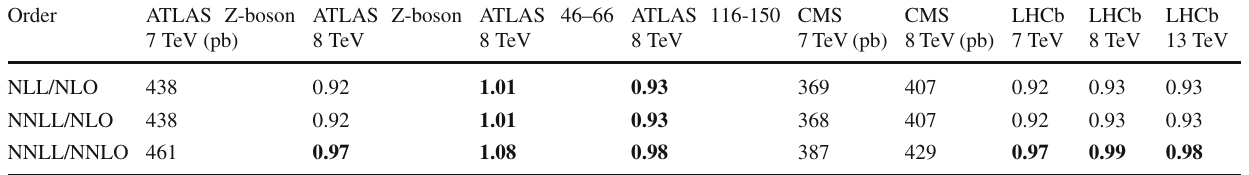
Table 11 The normalization factors for the cross-section for each experiment. The dimensional-less numbers are ratios of partially inte- grated cross section over q T (51) (theory/experiment, i.e. N − 1 ), for the datawiththepublishedvalueoftotalcross-section.Forthedatasetswith unpublished values of total cross-section, the value of the total cross-